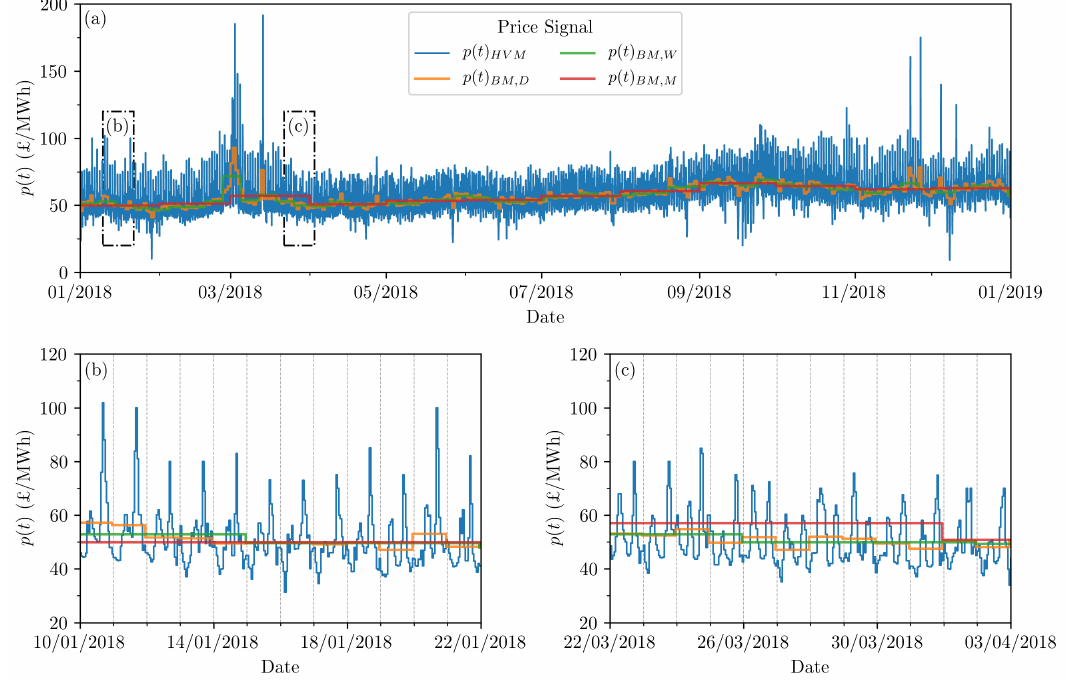
Figure 5. Hourly Variable p ( t ) HVM and corresponding Baseload Market price signals ( £ /MWh). p ( t ) BM , D , p ( t ) BM , W , p ( t ) BM , M refer to daily, weekly and monthly averaging